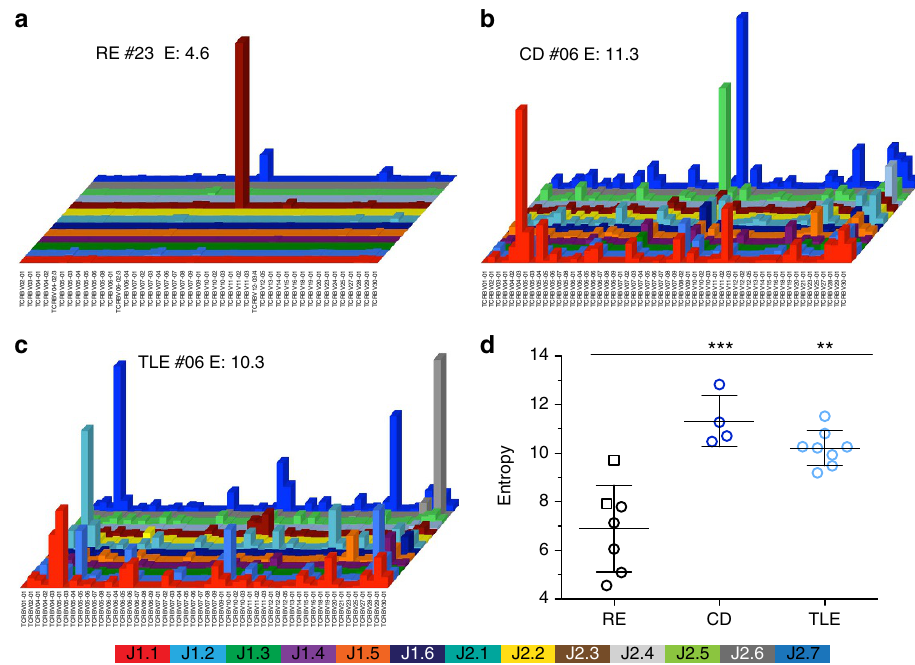
Figure 2 | RE patients’ CNS TCR repertoire is highly restricted. Shown are the CNS TCR repertoires of representative patients for ( a ) RE, ( b ) CD, ( c ) TLE. The x axis lists all analysed V b genes, the z axis the J b genes and the column height indicates the total reads of this specific V/J combination; entropy is given. ( d ) Quantification of the repertoire diversity by showing the TCR repertoire entropy of each patient group (RE: black n ¼ 7; CD: dark blue, n ¼ 4; TLE: light blue, n ¼ 8, mean ± s.d., unpaired t -test with Welch’s correction). Open circles indicate brain biopsy specimen and open squares indicate CSF